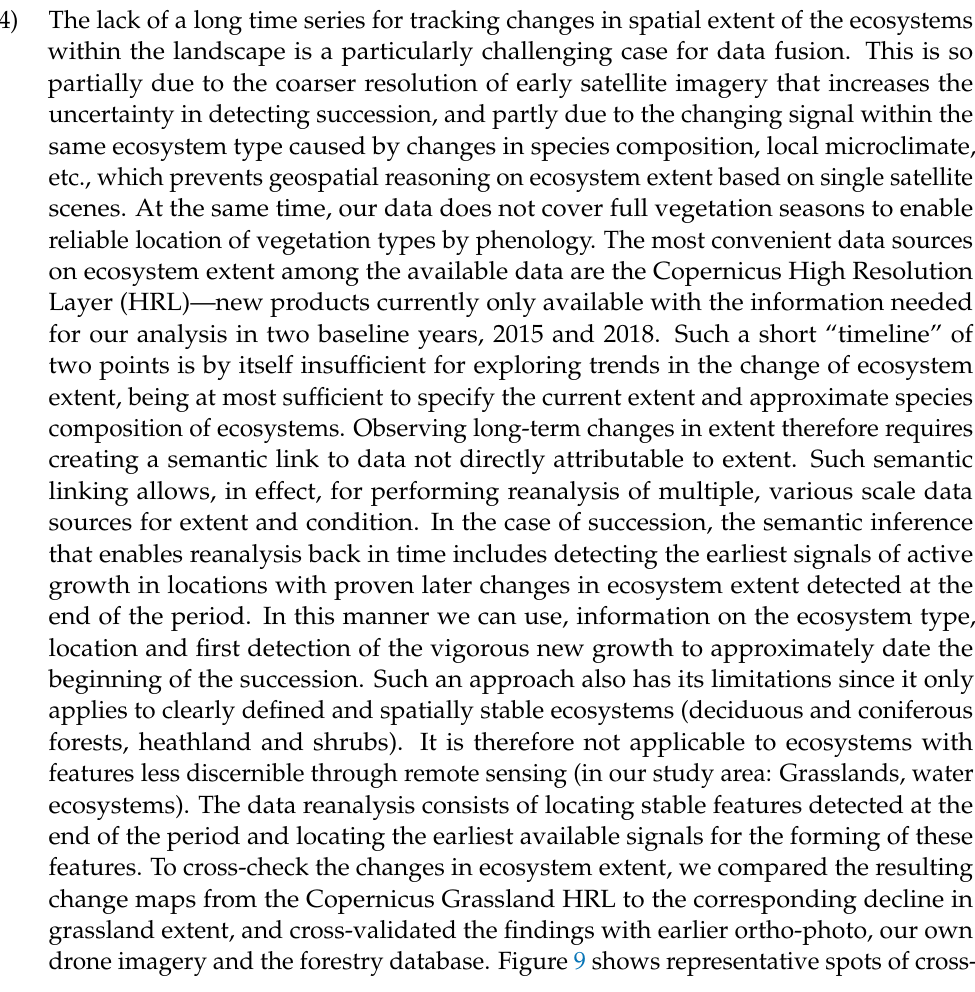
Figure 8. Relation between NDGI and the respective climate conditions: ( a ) TM of NDGI between 22 August 1977 and 23 May 1984 and diagram of climate parameter dynamics for 1984; ( b ) TM of NDGI between 27 June 1985 and 29 June 1994 and diagrams of climate parameter dynamics for 1985 and 1994; ( c ) TM of NDGI between 3 July 1987 and 11 July 1990 and diagrams of climate parameter dynamics for 1987 and 1990; ( d ) TM of NDGI between 13 June 2009 and 23 September 2011 and diagrams of climate parameter dynamics for 2009 and 2011; ( e ) TM of NDGI between 12 August 2019 and 13 September 2019 and diagram of climate parameter dynamics for August and September 2019.